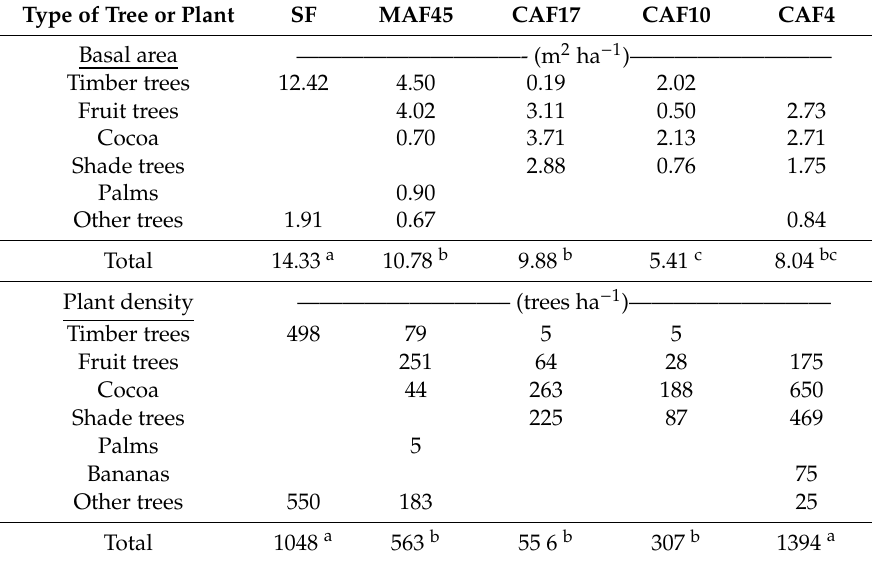
Table 3. Tree basal area and plant density of remnant secondary forest (SF), multistrata agroforest that is 45–68 years old (MAF45), cocoa agroforestry that is 17–34 years old (CAF17), cocoa agroforestry that is 10–12 years old (CAF10), and cocoa agroforestry that is 4–5 years old (CAF4). The high plant density for CAF4 was mainly due to a high population of cocoa and shade trees introduced into the system. Shade trees are trees mainly planted to provide shade for cocoa, but several types also fix atmospheric nitrogen and thus improve soil fertility. Type of Tree or Plant SF MAF45 CAF17 CAF10 CAF4 Basal area 12.42 Fruit trees